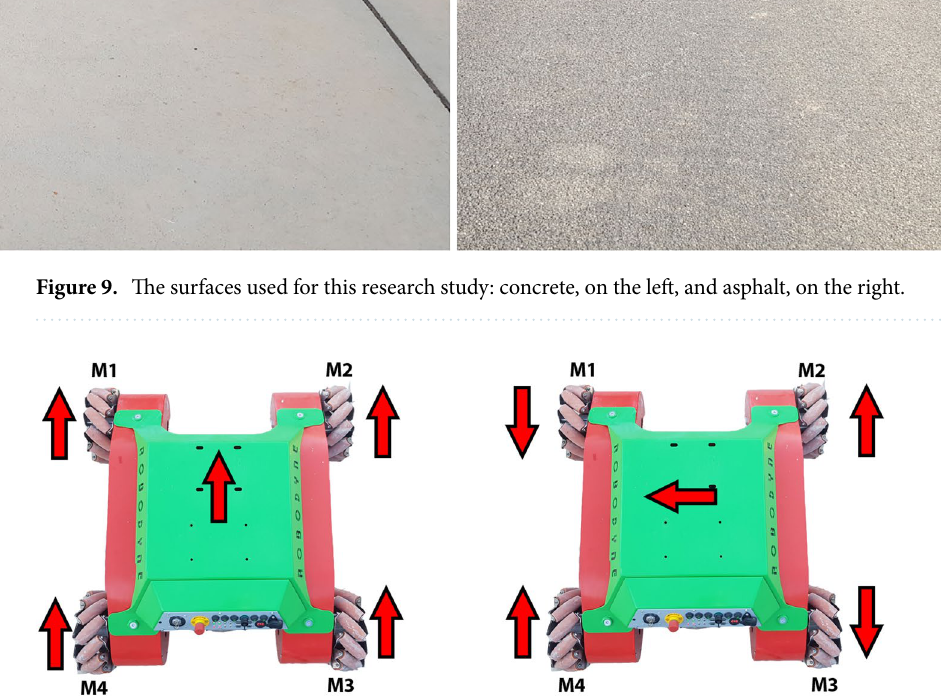
Figure 10. Wheel spinning configuration for the two motion primitives used for the tests.